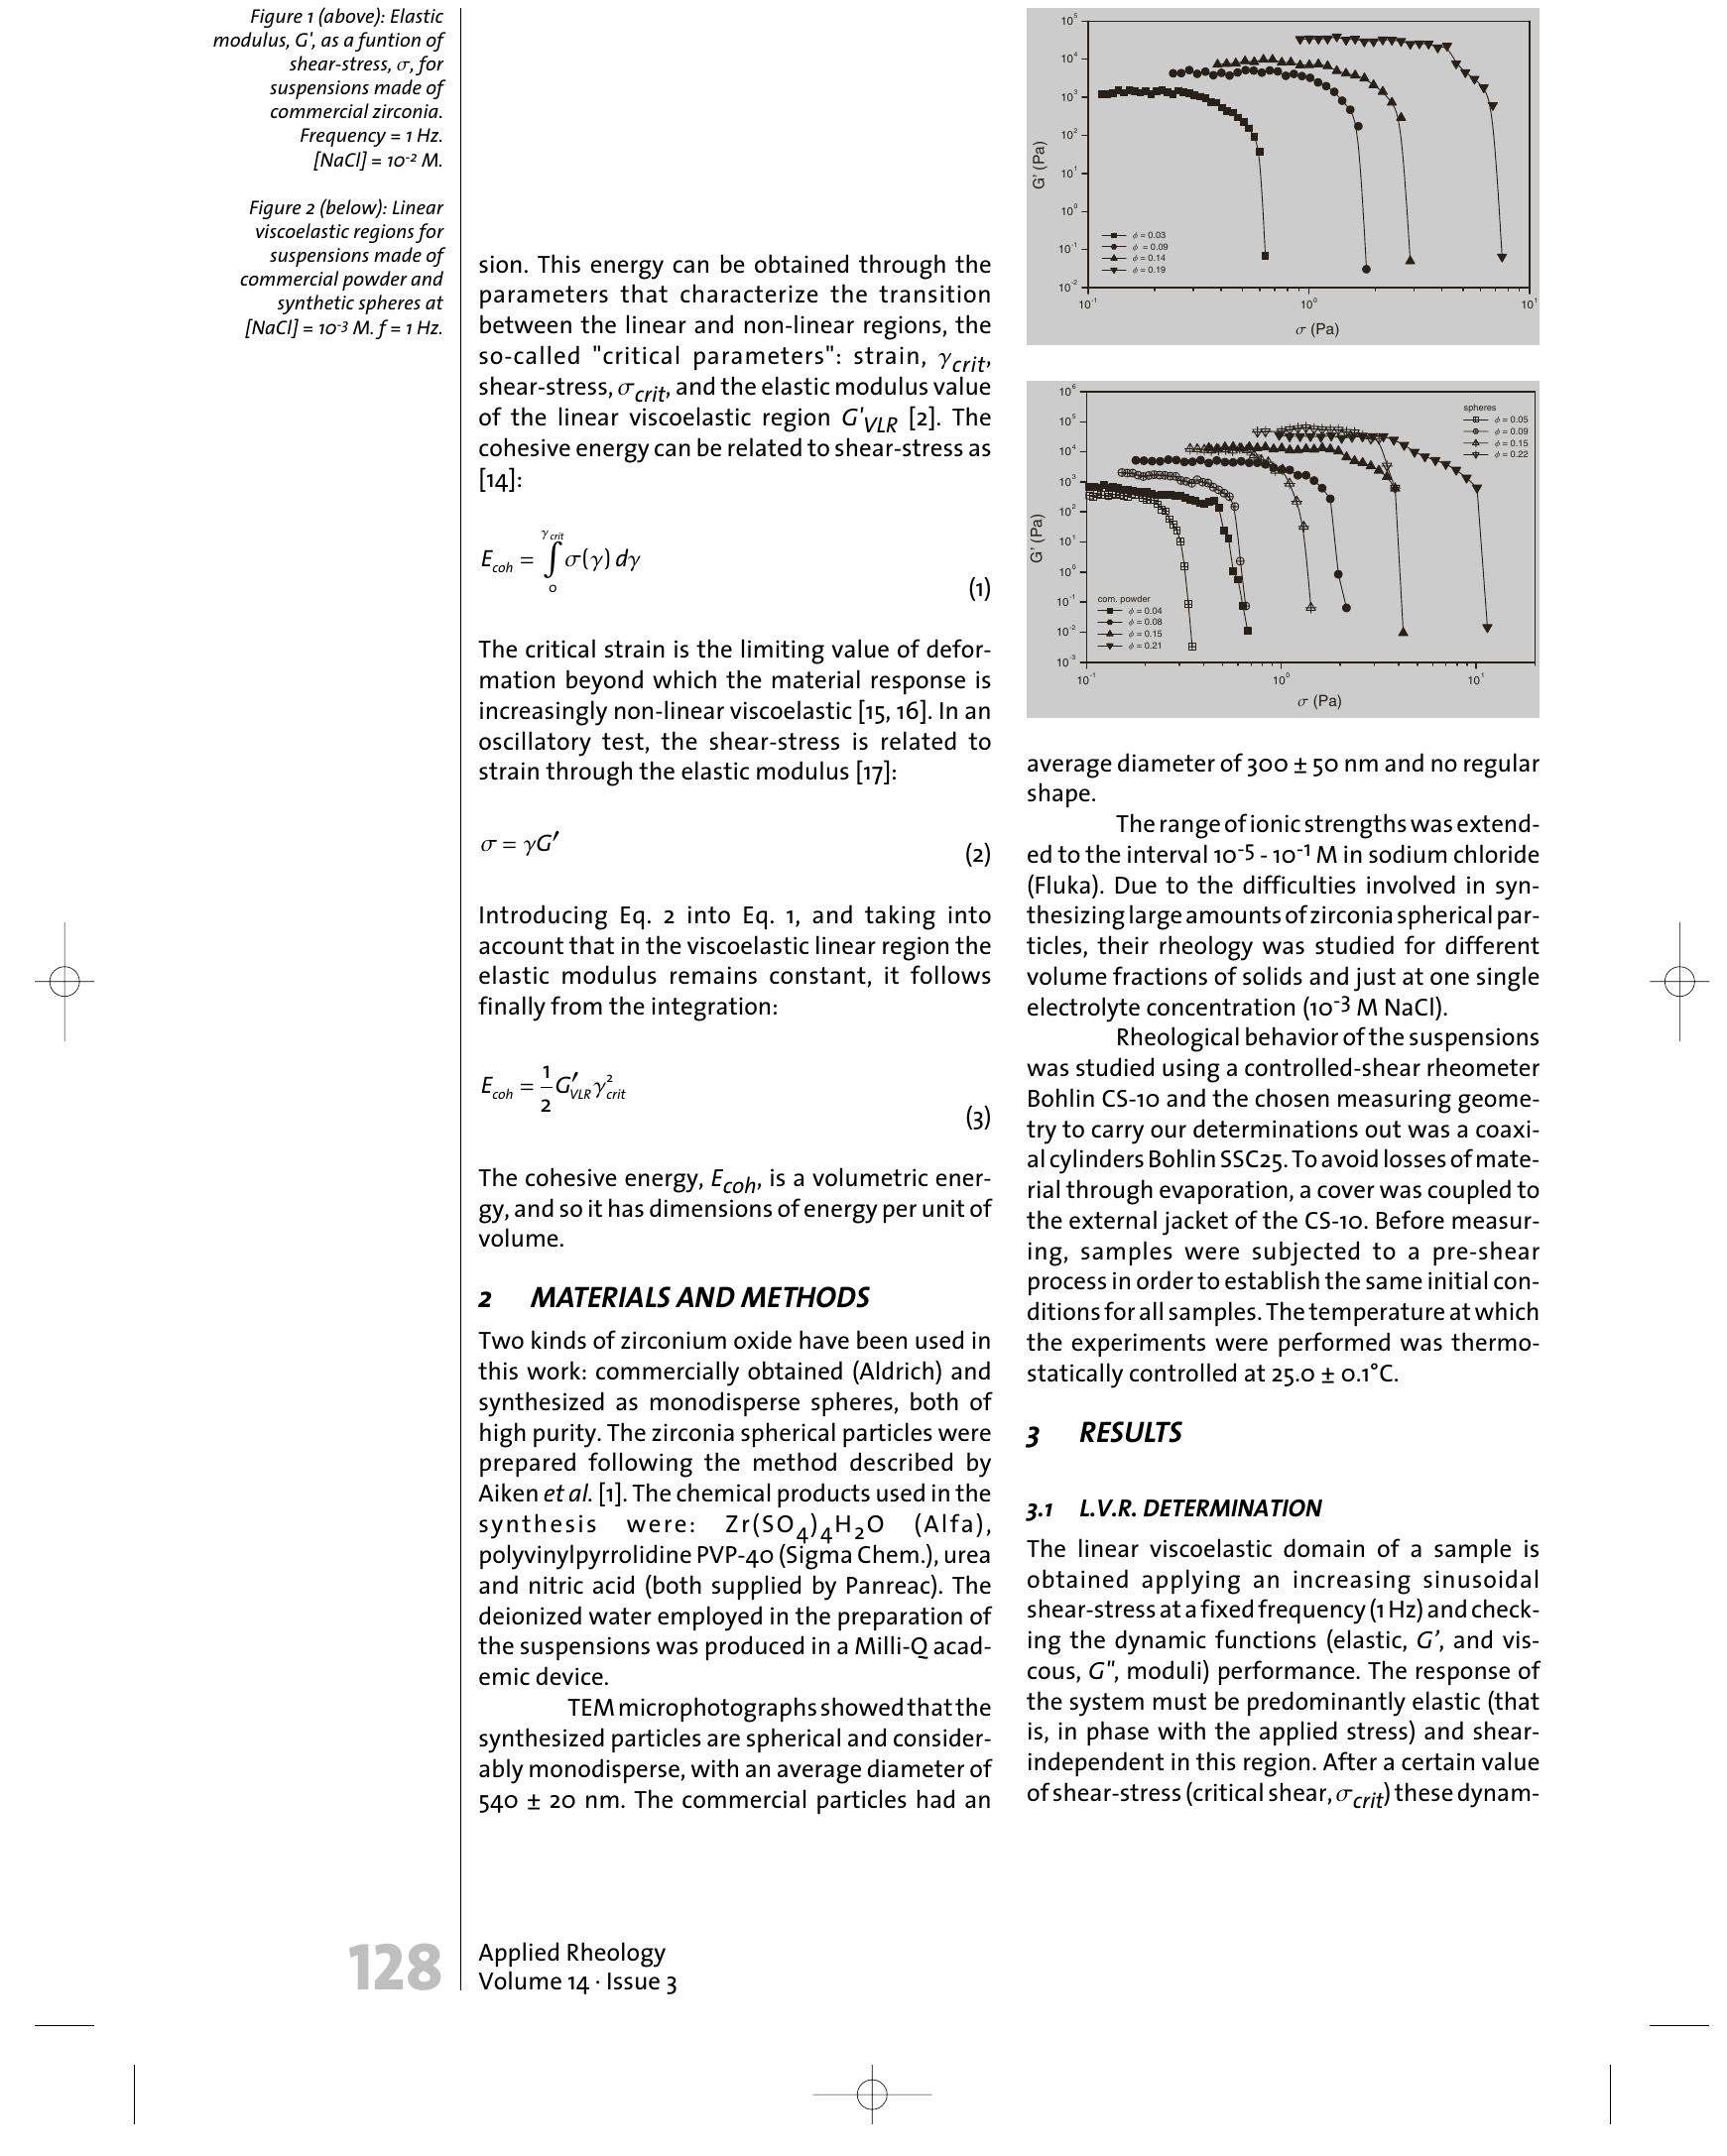
Figure 2 (below): Linear viscoelastic regions for suspensions made of commercial powder and synthetic spheres at [NaCl] = 10 -3 M. f = 1